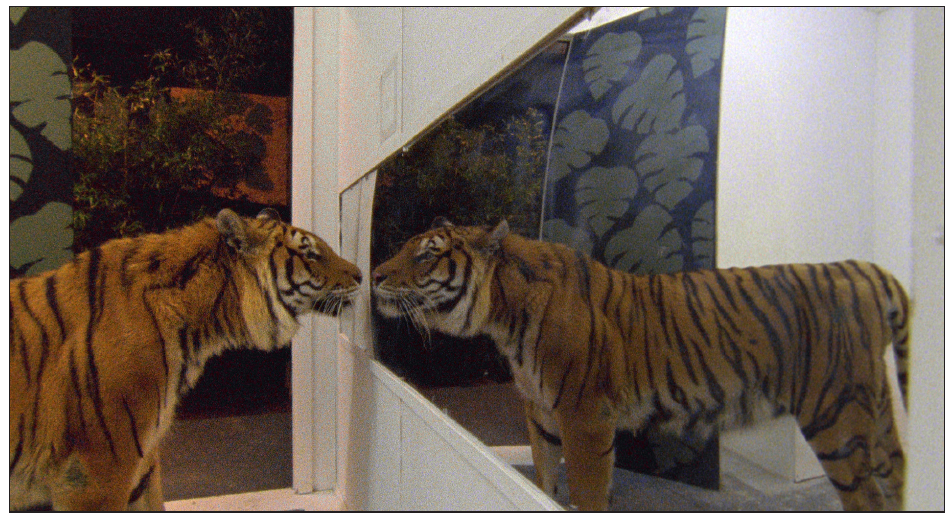
Figure 3: ‘Ming of Harlem’, Phillip Warnell, 2016 © the artist: Phillip Warnell, Ming of Harlem, 2016 © the